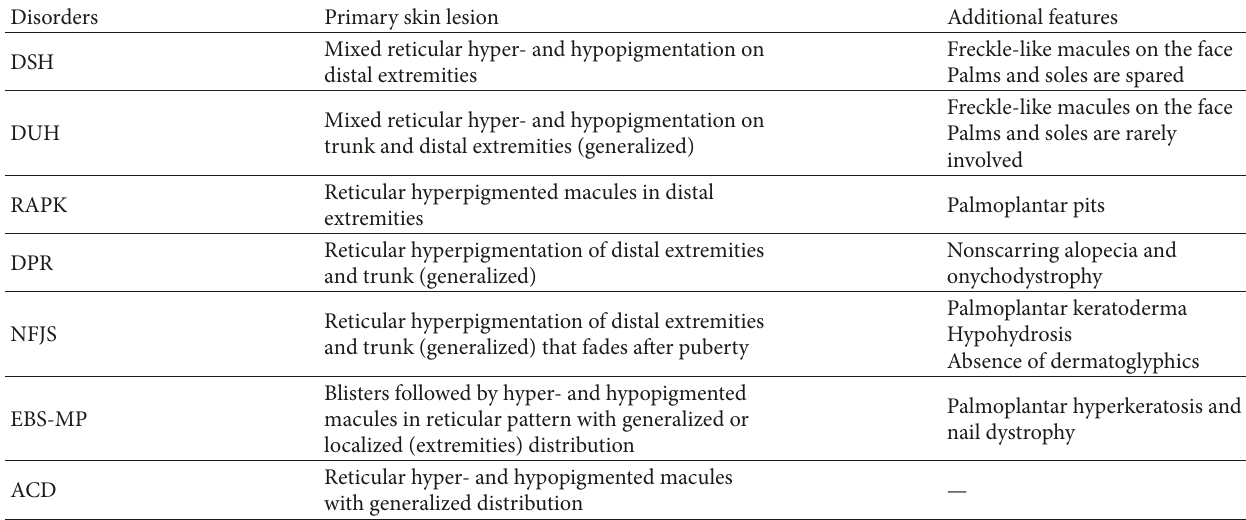
Table 1: Characteristic clinical features of hereditary reticulate pigmentary disorders.